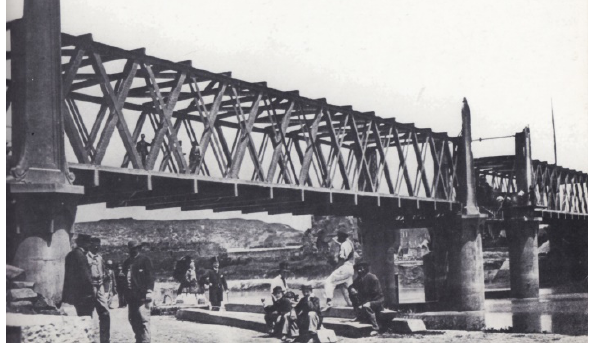
Figure 4. Industry Bridge at Ostiense quartier (Testa,